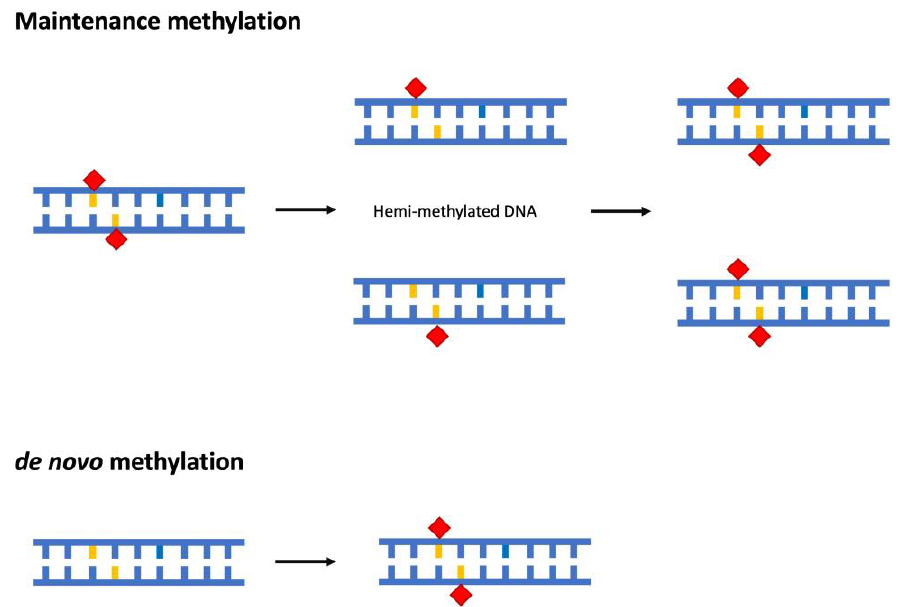
Figure 1. Schematic representation of maintenance and de novo methylation of DNA. The methyl group is indicated by red rhombus, whereas cytosine is indicated in orange.